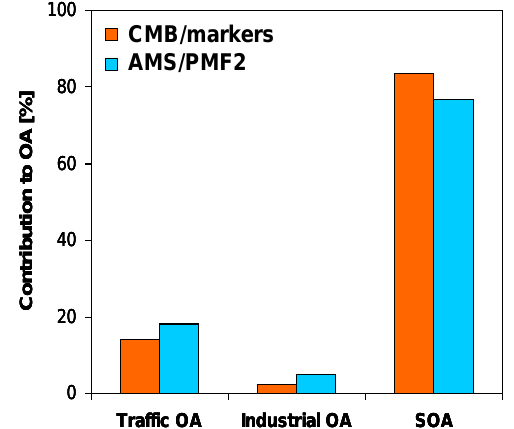
Fig.6: Comparison between CMB/markers and 1137 Fig. 6. Comparison between CMB/markers and AMS/PMF2. For AMS/PMF2. For the AMS/PMF2, Traffic OA, 1138 the AMS/PMF2, Traffic OA, industrial OA and SOA denote HOA, industrial OA and SOA denote HOA, F4 and the sum 1139 F4 and the sum of SVOOA and LVOOA, respectively. For CMB, of SVOOA and LVOOA, respectively. For CMB, 1140 industrial OA represents the aggregate contribution from three pro- industrial OA represents the aggregate contribution 1141 from three processes: coke production, metal smelting 1142 cesses: coke production, metal smelting and shipping/oil burning; and shipping/oil burning and SOA is the fraction that 1143 SOA is the fraction that is not apportioned to primary ] is not apportioned to primary sources. 1144